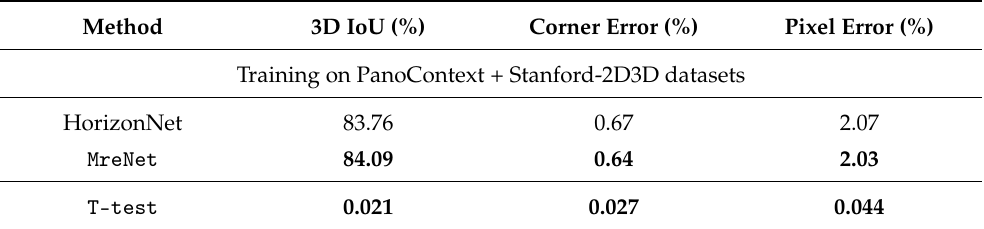
Table 3. Quantitative results of cuboid layout estimation evaluated on the Stanford-2D3D [25]+ PanoContext dataset [24]. Our approach outperforms all listed methods under all